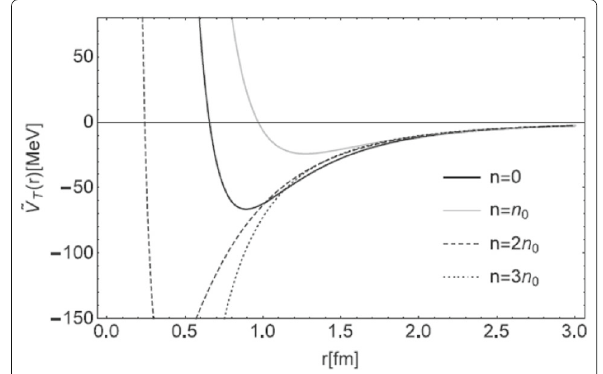
(cid:3) (cid:4) V T π + V T ρ with ∗ ≈ (cid:13) 2 for n > n ρ 1 / 2 and R